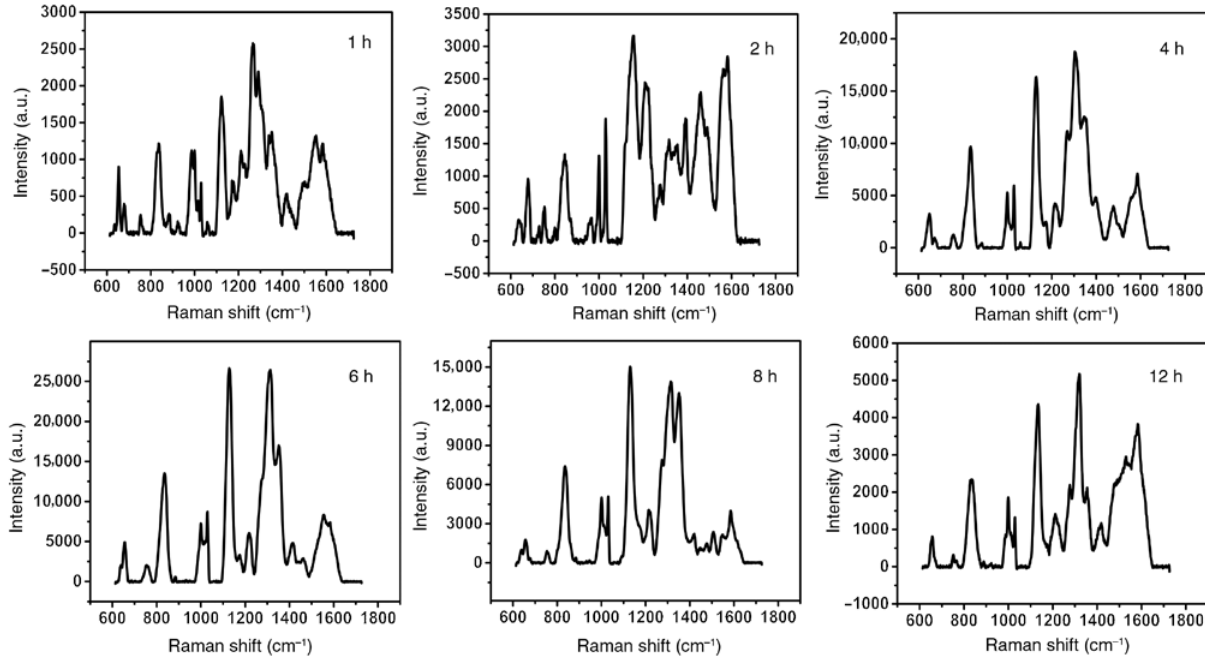
Figure 3: Average SERS spectra of HepG2 cells incubated with BP-Au NSs for 1, 2, 4, 6, 8 and 12 h,